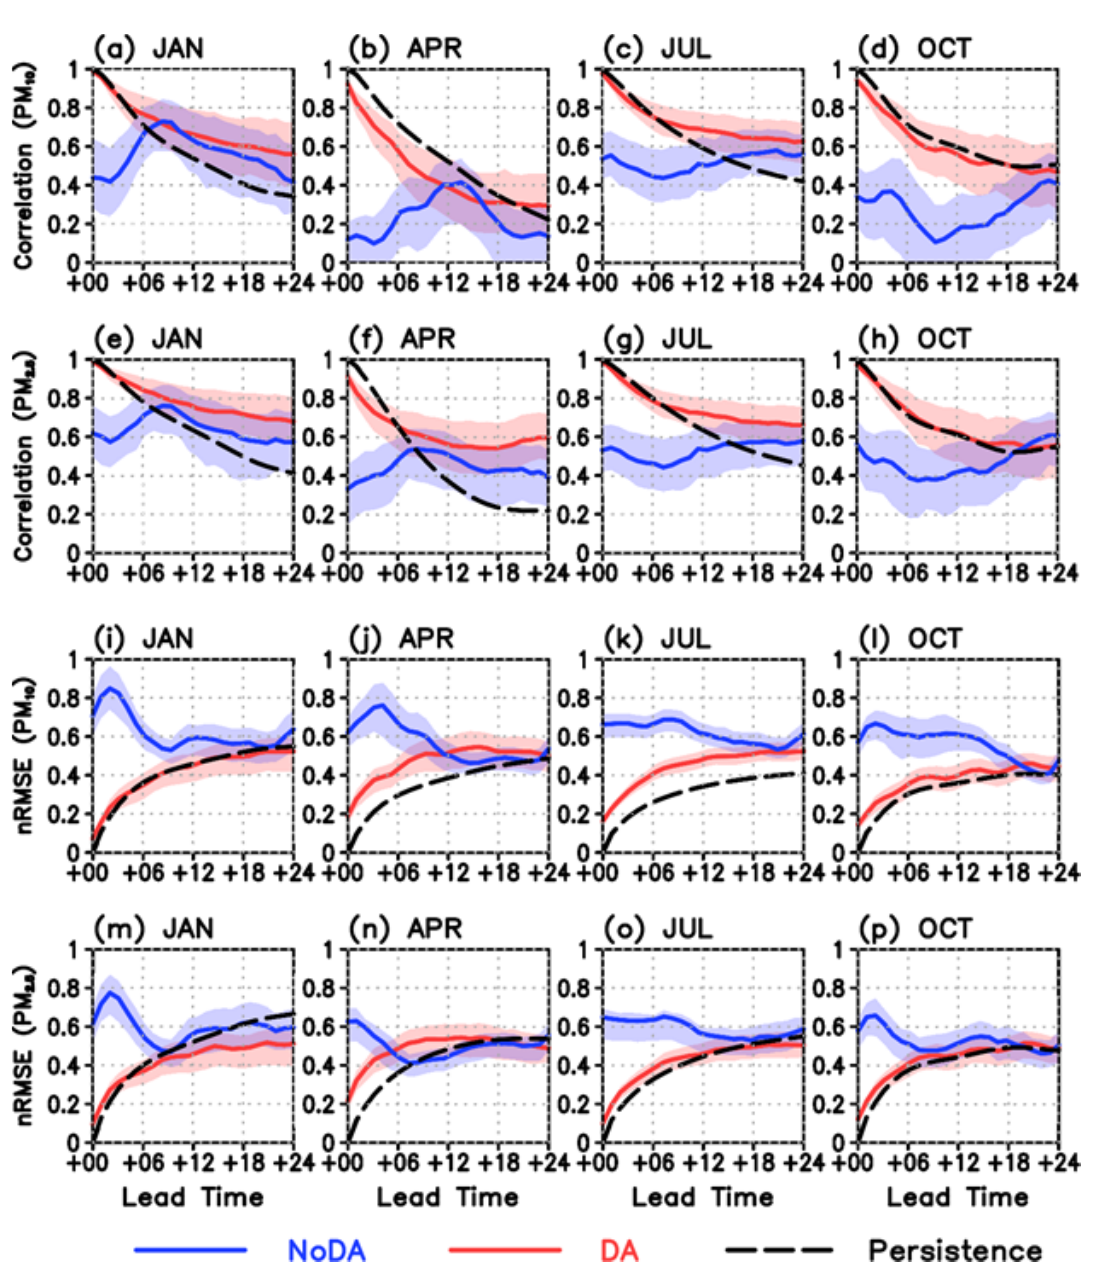
Figure 10. ( a – h ) Correlation coefficient and ( i – p ) normalized RMSE (nRMSE) curves for the NoDA (blue) and DA (red) forecasts and persistence curves (black dotted) in each month. Other parameters are the same as in Figure 9.